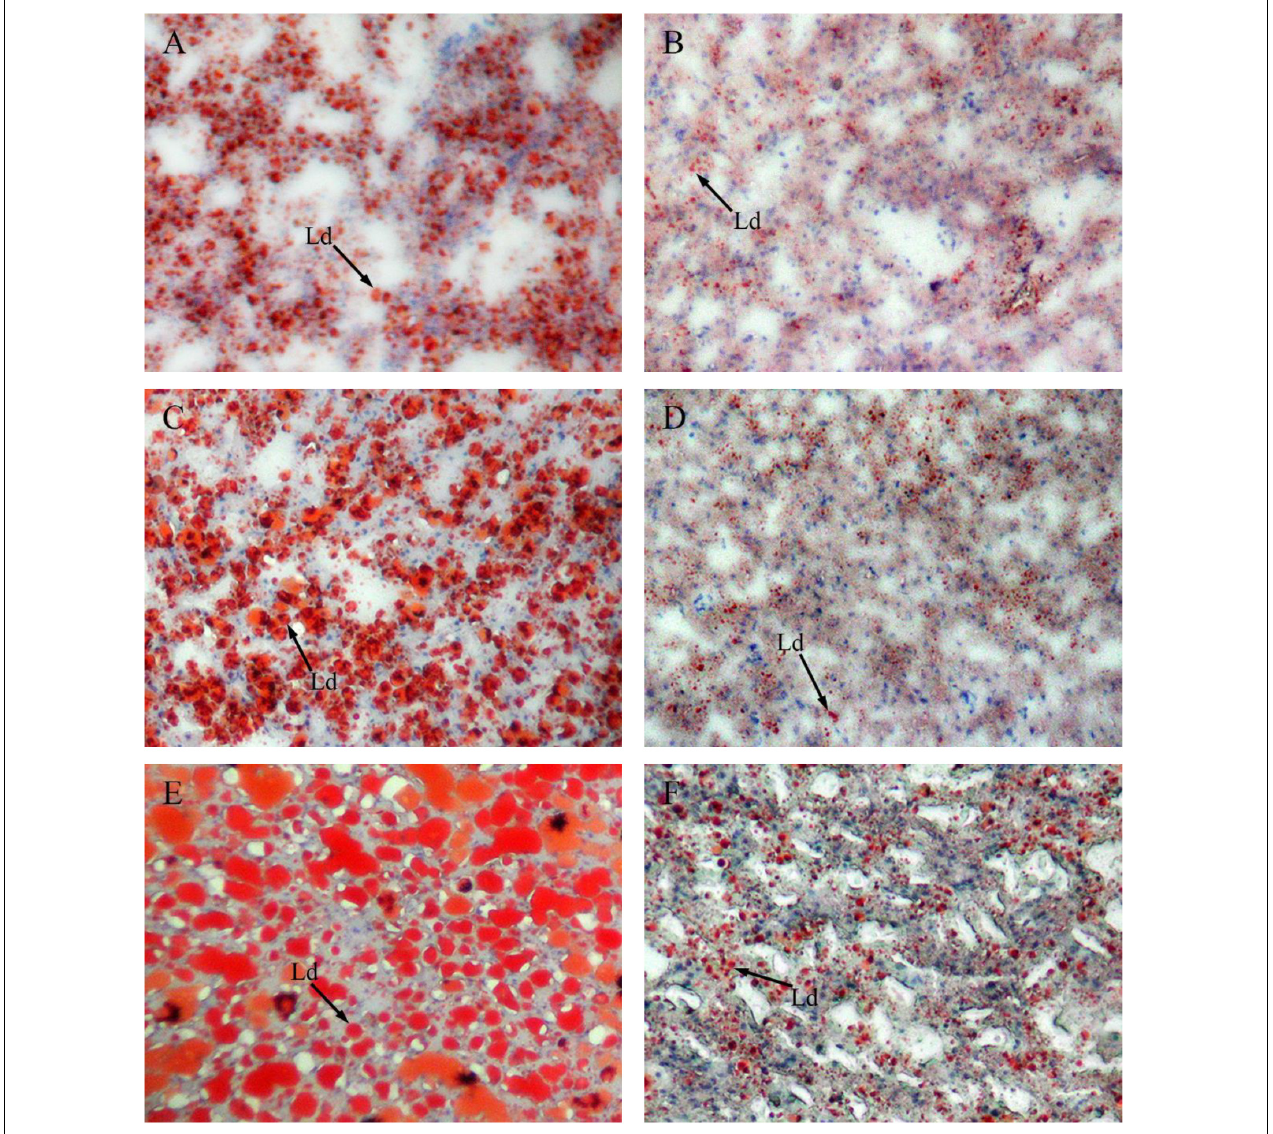
FIGURE 5 | Red oil O staining of liver tissues of GIFT fed experimental diets on day 20, 40, and 60. Magnification 200 × . (A) Fish fed high-fat diet (HFD, 18.5% lipid level) for 20 days; (B) fish fed normal-fat diet (NFD, 8% lipid level) for 20 days; (C) fish fed HFD for 40 days; (D) fish fed NFD for 40 days; (E) fish fed HFD for 60 days; (F) fish fed NFD for 60 days. Ld, lipid